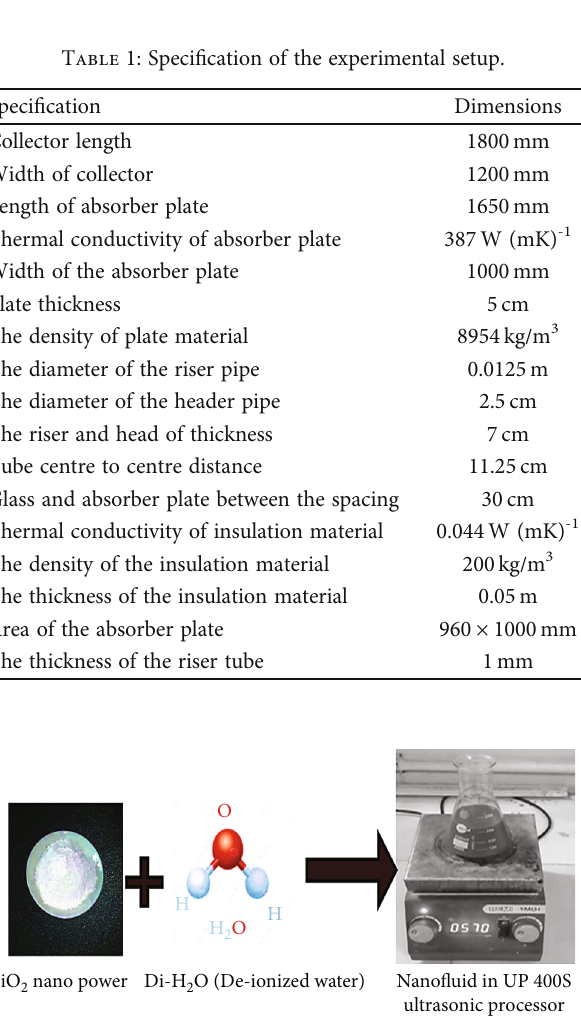
Figure 2: Ultrasonic dispersion setup for the preparation of nano fl uid.